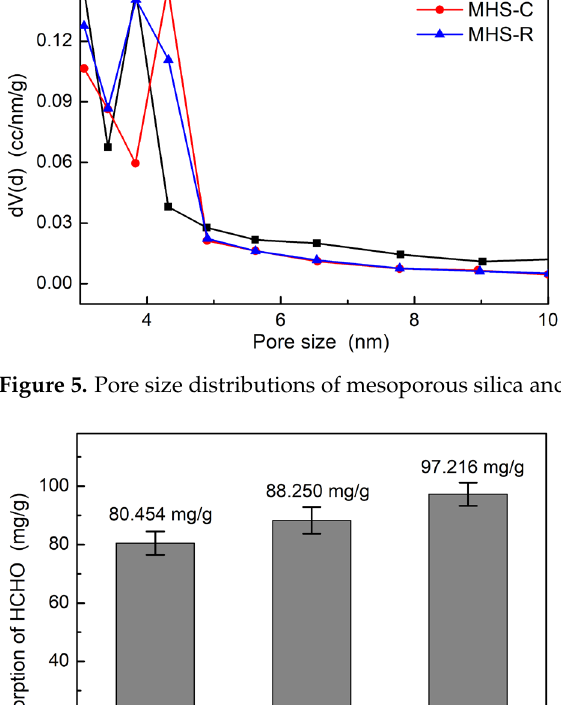
Figure 7. FT-IR spectra of mesoporous silica and mesoporous hollow silica nanomaterials after formaldehyde adsorption. 3. Materials and Methods 3.1. Materials For the synthesis of hollow mesoporous silica, TEOS (tetraethyl orthosilicate, 98 wt%, Sigma-Aldrich-Korea, Seoul, Republic of Korea) and sodium silicate solution (28–30 wt%,